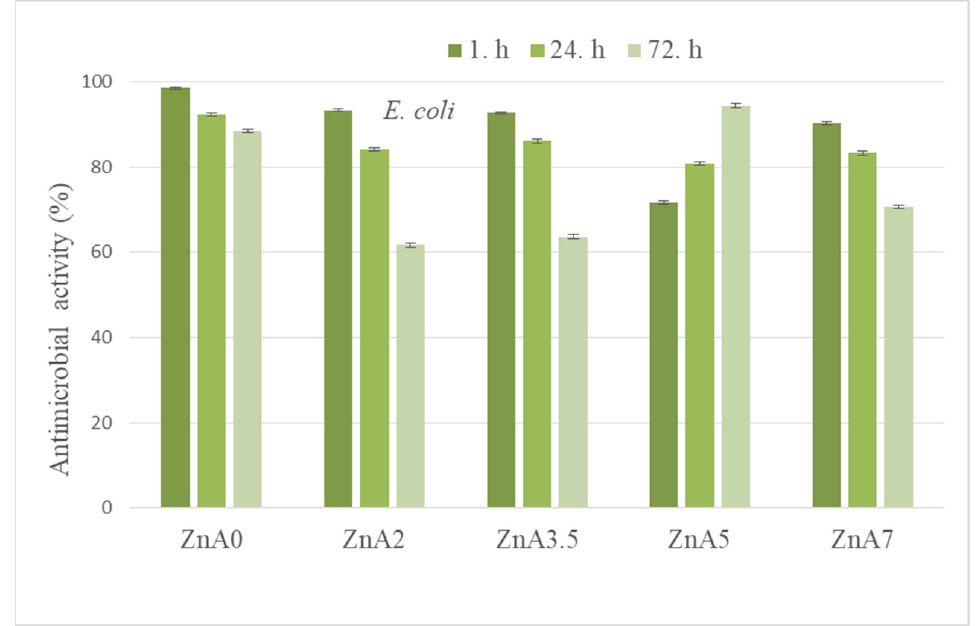
Figure 5. Antimicrobial activity of zinc(II) ions in poly(acrylate/itaconic acid) matrices in contact with E. coli .